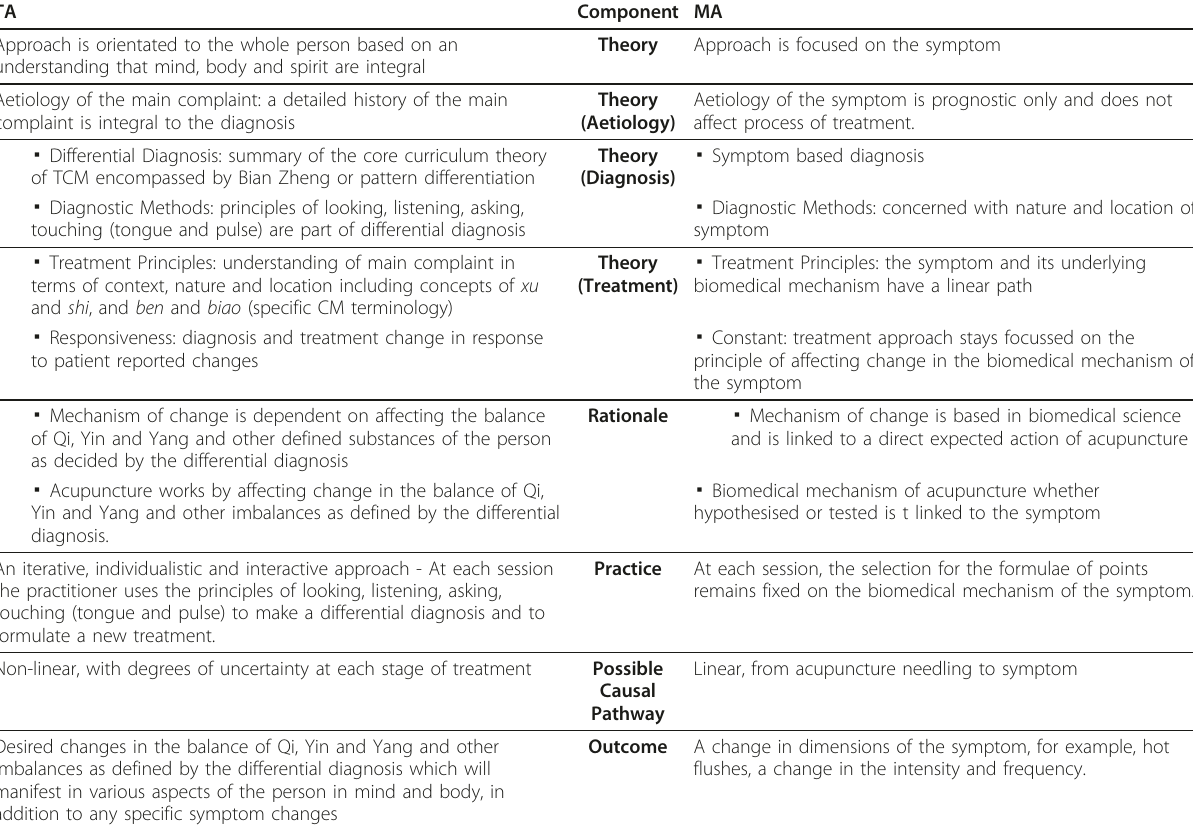
Table 1 Differentiation of theory, rationale, practice and outcome for two models of acupuncture (see text for more detailed